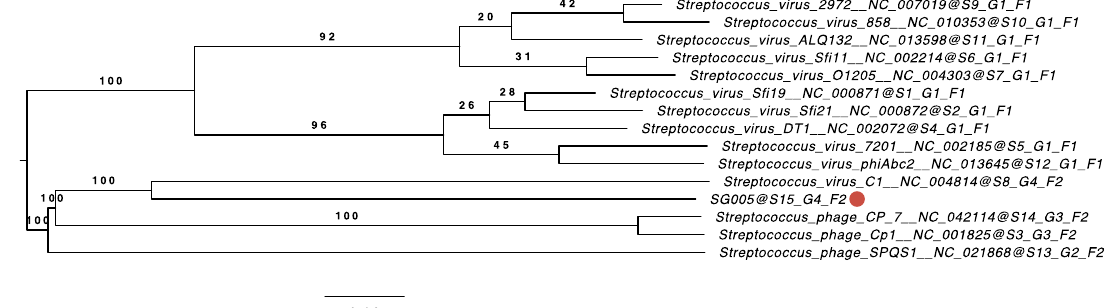
Figure 4. Phylogenetic analysis using the whole-genome sequence of Φ SG005. The phylogenetic tree was constructed by VICTOR using 14 whole-genome sequences of all streptococcus master species registered by the International Committee on the Taxonomy of Viruses (ICTV). The red circle indicates Φ SG005. S, G, and F after the phage names refer to species, genus, and family clusters, respectively.